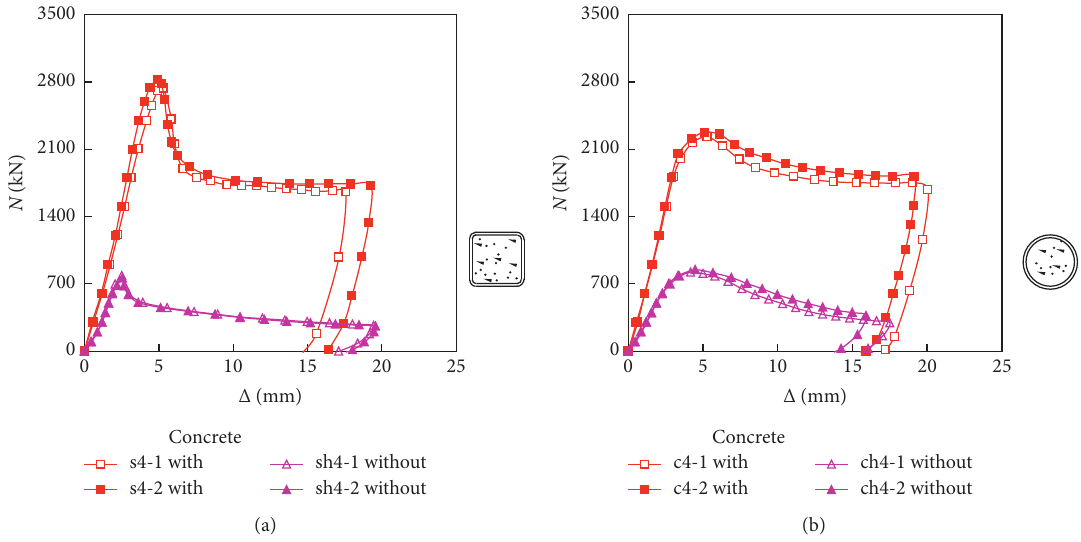
Figure 9: Load ( N ) versus deformation ( Δ ) diagrams with or without concrete infill. (a) Square section. (b) Circular section.